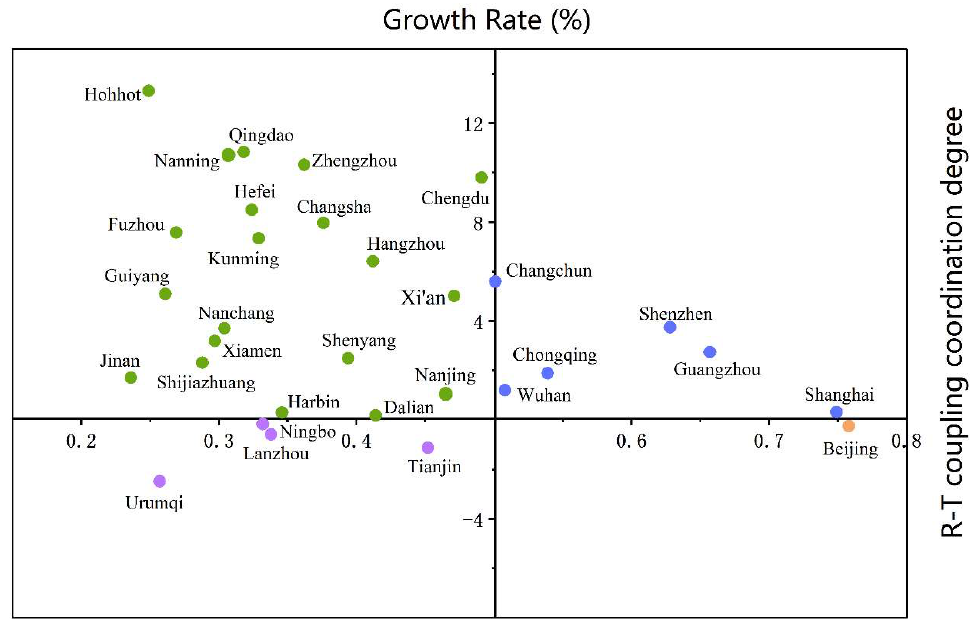
Figure 8. Coupling coordination relationship of R-T in 31 cities in China.